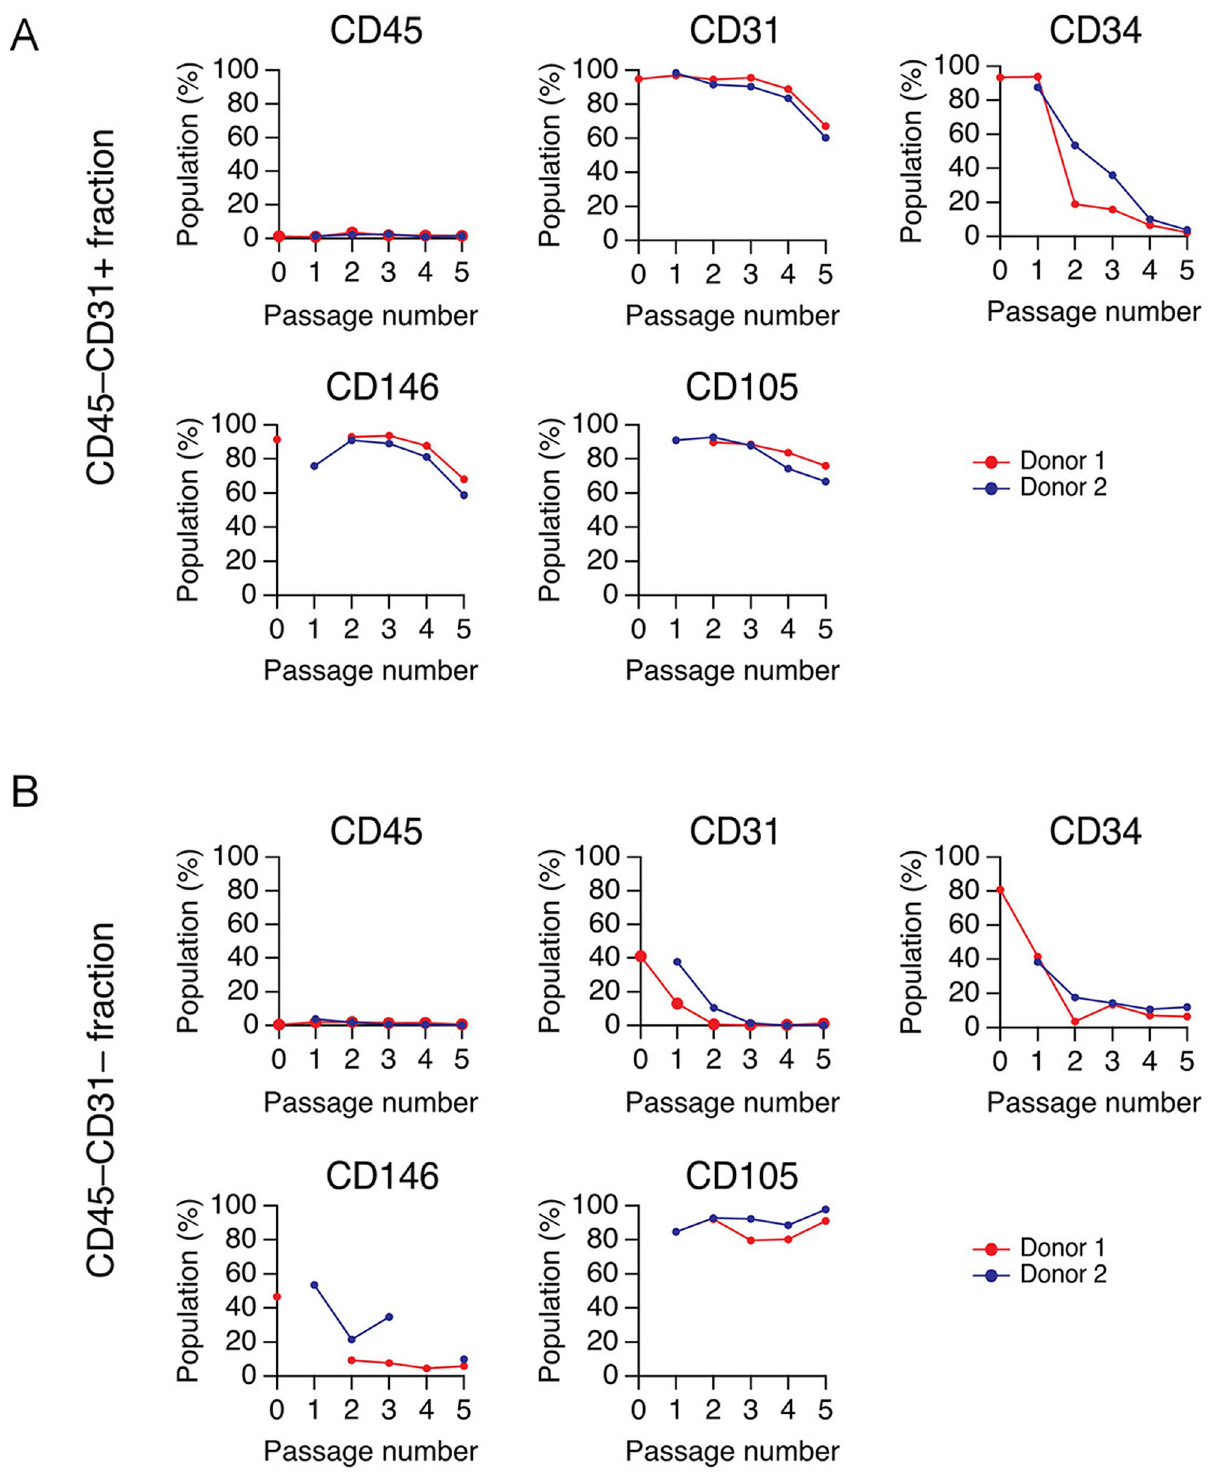
Figure 4. Time-dependent changes in AEPC cell morphologies and surface marker expression profiles. ( A ) The CD45 − CD31 + and ( B ) CD45 − CD31 − MACS-separated fractions were characterized for the expression of CD markers, including CD45, CD31, CD34, CD146, and CD105. The experiment was performed twice, independently from 2 donors. The graph indicates 2 donors, depicted by red and blue lines. The X-axis (passage number) indicates that the CD45 − CD31 + fraction at P5 corresponded to dissociated AEPCs at P4D4, as shown in Fig.